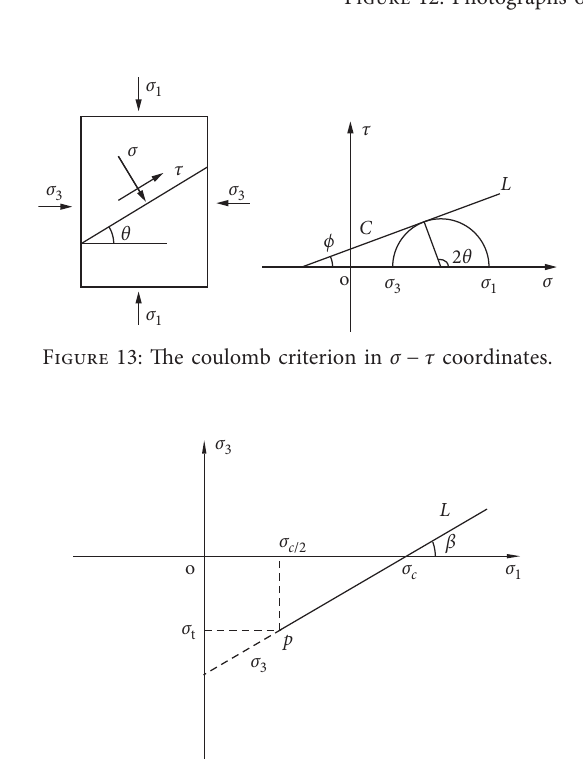
Figure 12: Photographs of some damage in the tensile test.